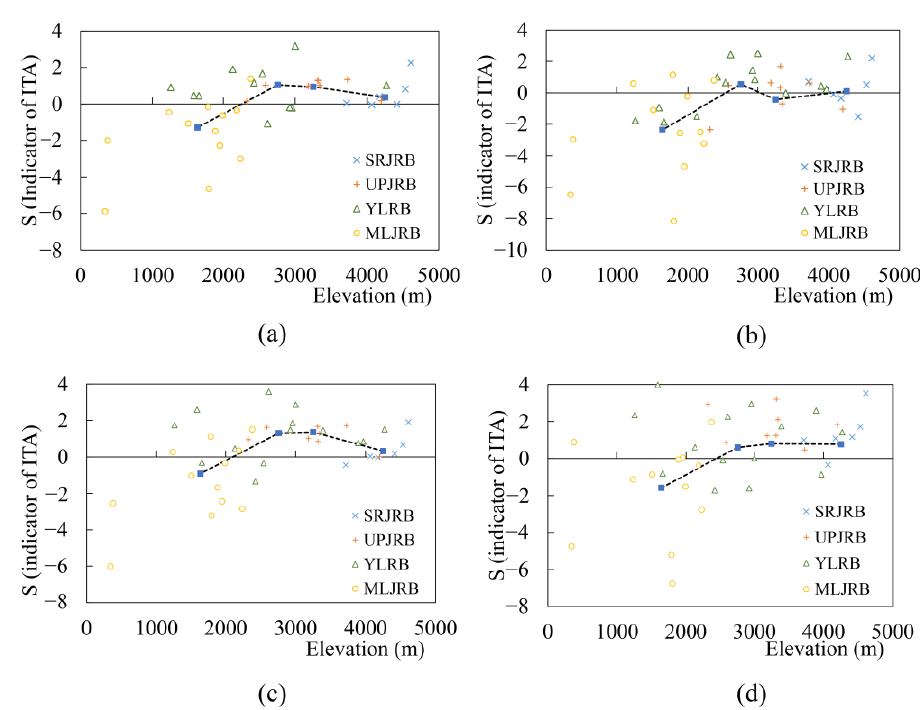
Figure 12. Correlation between elevation and temperature time series of ( a ) annual precipitation, ( b ) low category precipitation, ( c ) medium category precipitation, and ( d ) high category precipitation during 1961–2016 in the JRB. Black dashed lines show the average values for all sub-basins.